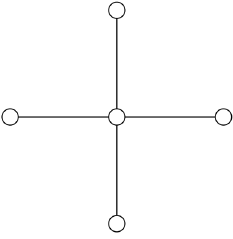
Figure 1. The star graph on five